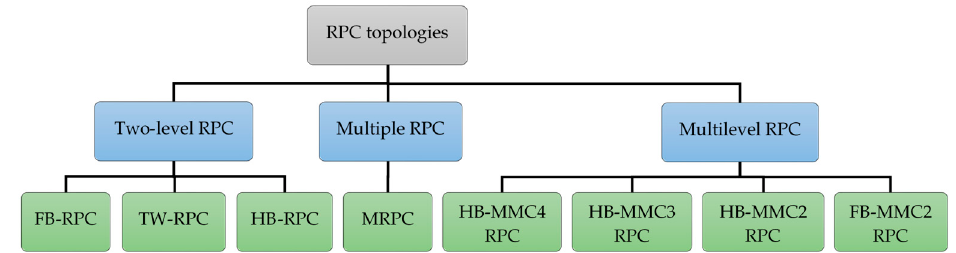
Figure 2. Classification of the RPC topologies (based on [6–8,10]).